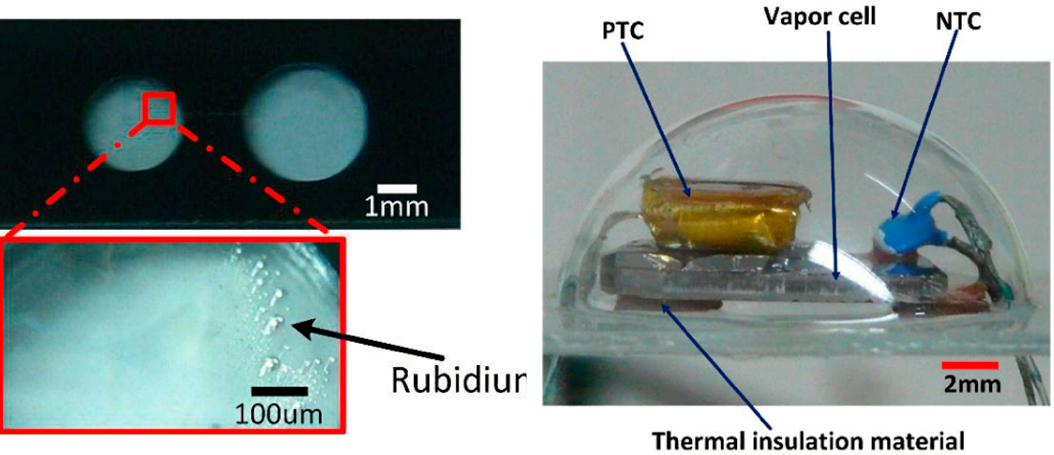
Figure 23. Glass encapsulation micro-fabricated vapor cell and heating and temperature measurement structure (Southeast University, 2015). Reprinted from Ref [110].